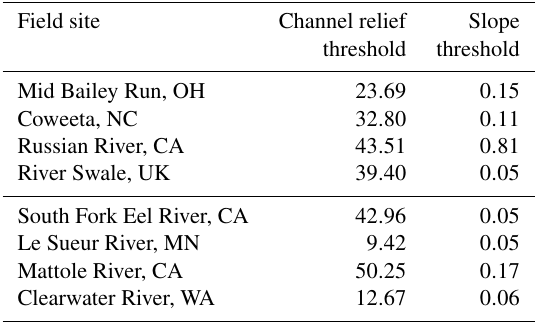
Table 1. Channel relief and slope threshold for each field